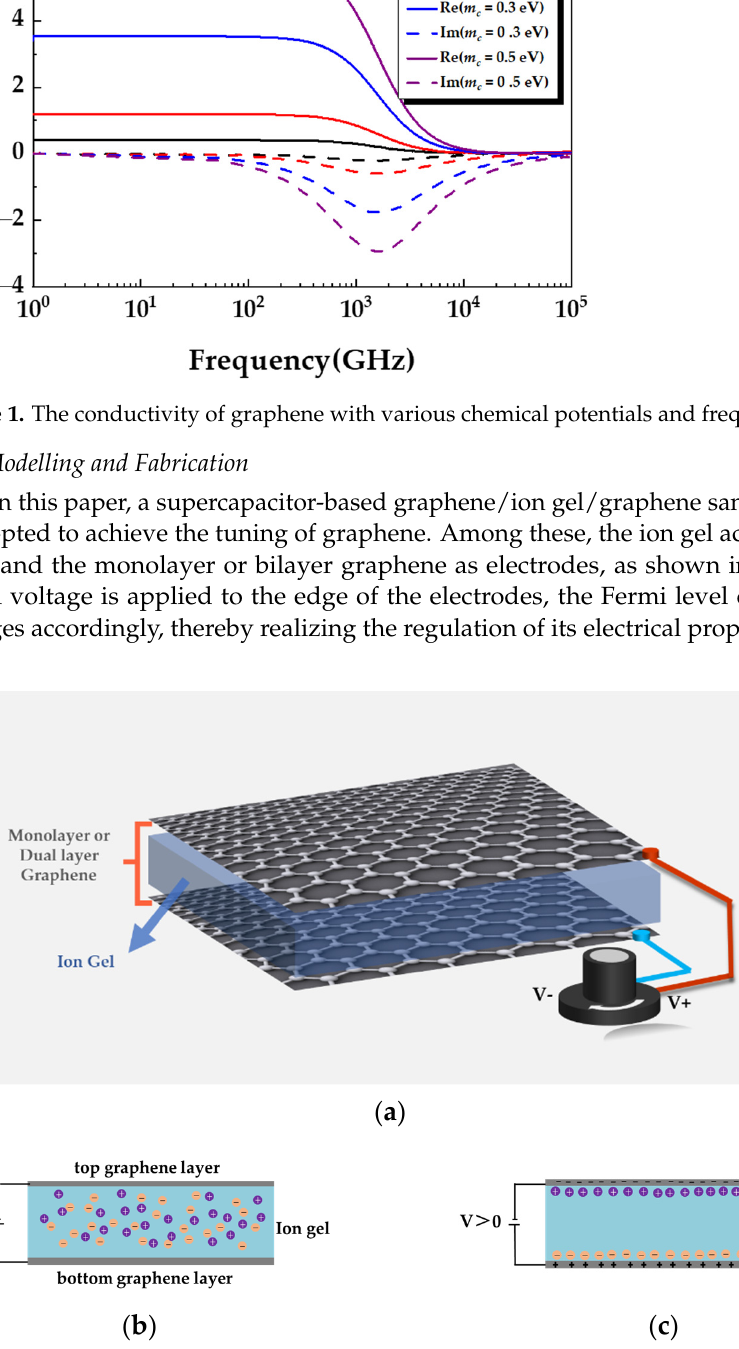
Figure 2. The diagram of GIG sandwich structure and regulation principle: ( a ) the schematic of GIG sandwich structure; ( b , c ) the distribution of charge, ( b ) without and ( c ) with bias voltage.